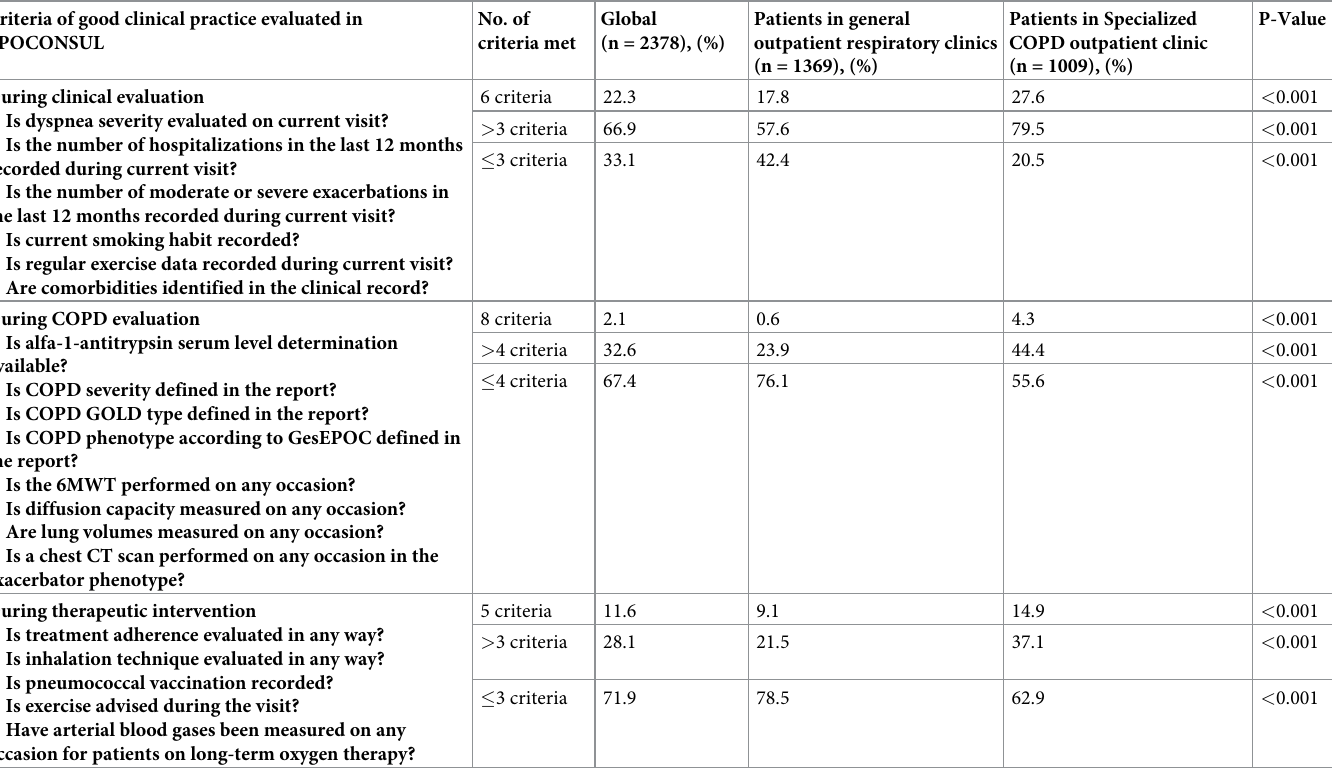
Table 6. Adherence to recommendations (GOLD and GesEPOC) in both outpatient clinic models. Criteria of good clinical practice evaluated in